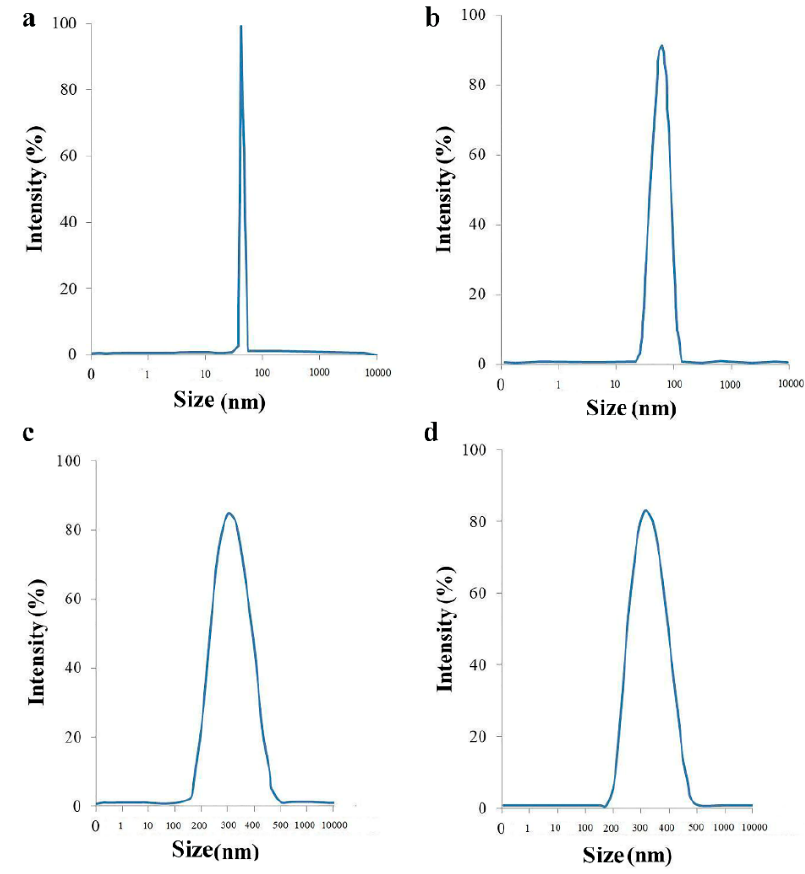
Figure 3. Size distribution analysis of ( a ) Fe 3 O 4 , ( b ) Fe 3 O 4 @HPG, ( c ) Fe 3 O 4 @SiO 2 , and ( d